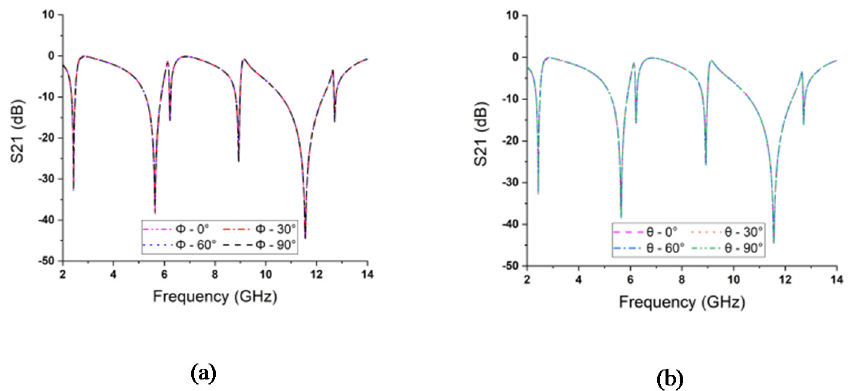
Figure 4. S21 response for different ( a ) polarization angles; ( b ) oblique incident angles. Table 1. Proposed unit cell parameters values.